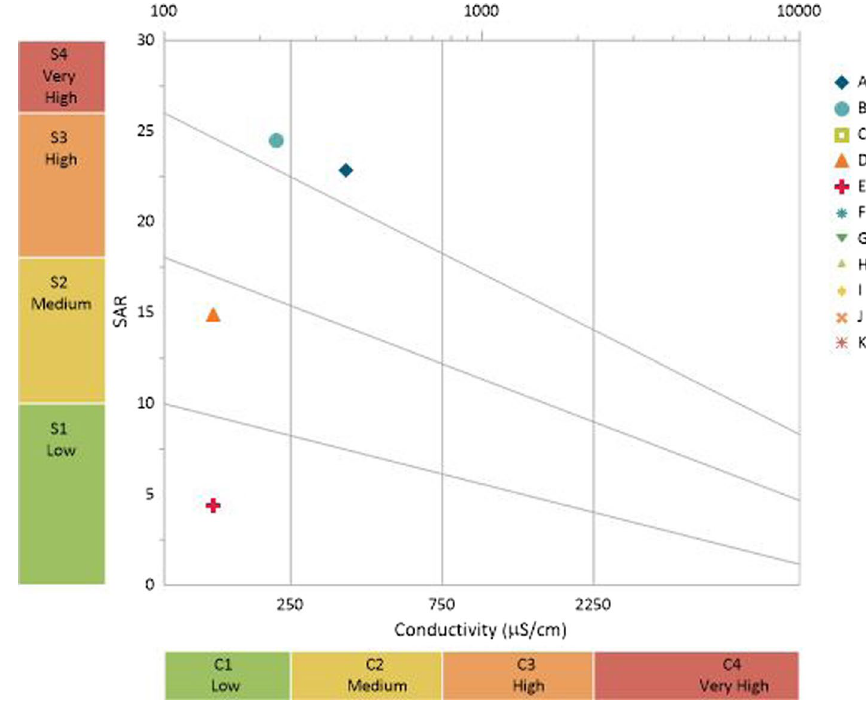
Fig. 6 United State Laboratory Irrigation water classification diagram based on SAR and